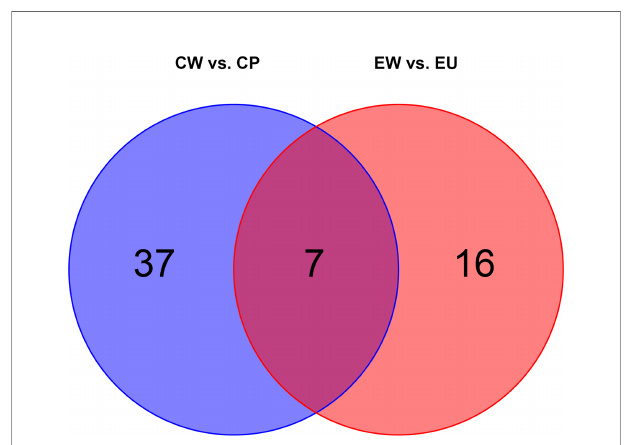
FIGURE 6 | Venn diagram showing common and unique metabolites (EW vs. EU and CW vs. CP groups). There are 16 and 37 unique differential metabolites in EW vs. EU and CW vs. CP groups, respectively. Seven differential metabolites were common between